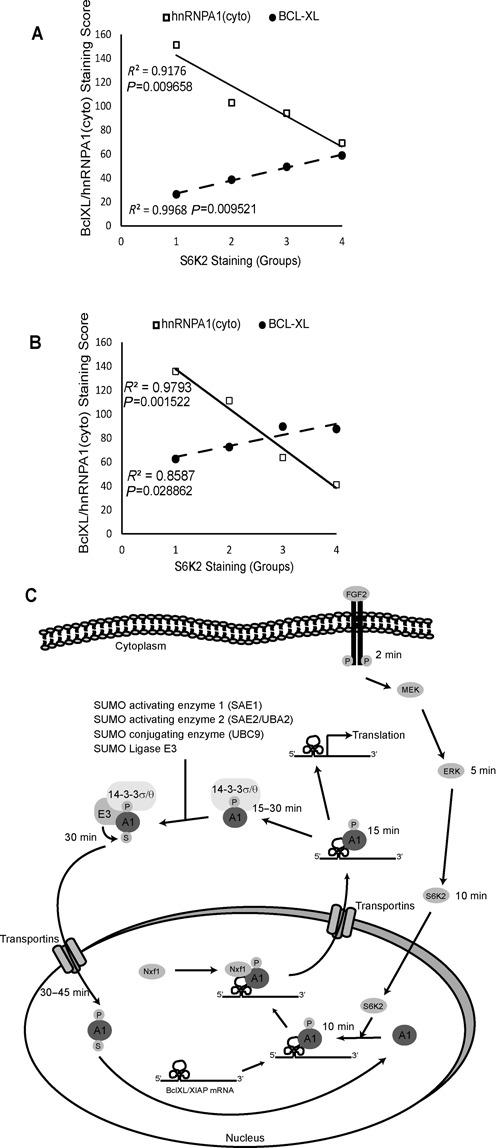
Immunohistochemical staining for S6K2, hnRNPA1 and BCL-XL. TMA samples from lung (n = 204) (A) and breast cancer (n = 194) (B) patients were stained for S6K2, hnRNPA1 and BCL-XL. An increase in S6K2 staining correlates with concomitant increase in BCL-XL and decrease in cytoplasmic hnRNPA1 staining. Patients were grouped (X axis; group 1–4) according to their staining scores for S6K2 and correlation curves between the staining intensities for BCL-XL and cytoplasmic hnRNPA1 with groups 1–4 plotted. Correlation coefficients and P-values (ANOVA test) are shown. (C) Schematic illustration of how FGF-2 signalling regulates the shuttling of hnRNPA1 and the translation of BCL-XL and XIAP mRNAs.